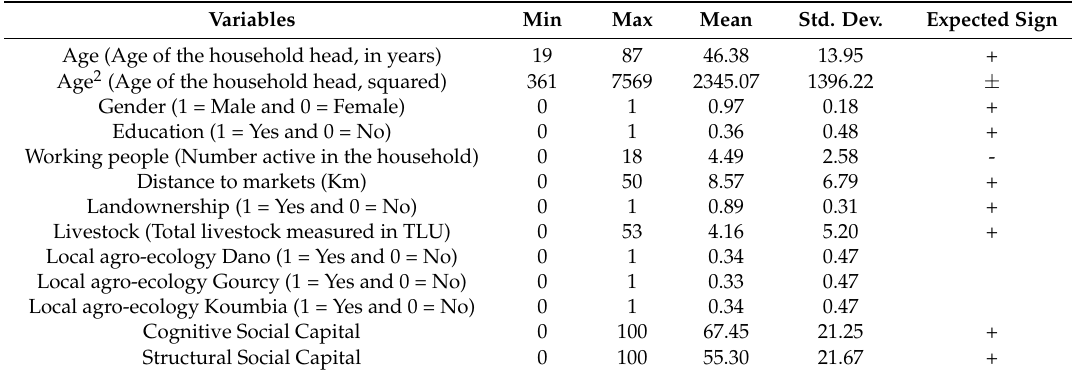
Table 1. Description of independent variables and their suggested